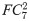
Amplifiers that become suppressors.From the symbolic computation of the differences Φ(r) − Φ0(r), we know that the friendship cycle FC72 (with identification number Id 1151592835082) becomes a suppressor from rc ≈ 4.98, and the friendship star FS74 (with identification number Id 1151592837126) becomes a suppressor from rc ≈ 24.79.